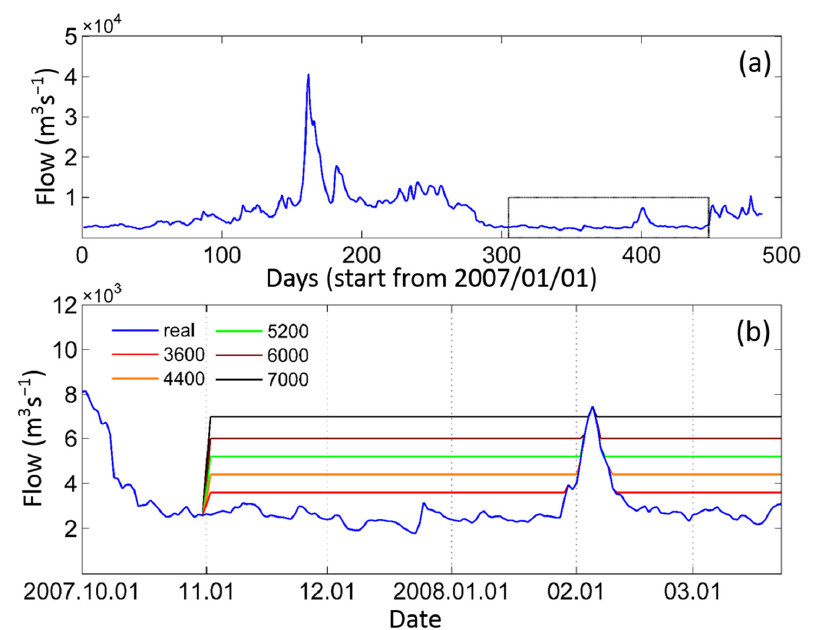
Figure 2. ( a ) River flow of the PRE from 1 January 2007 to 30 April 2008. ( b ) Flow modulation strategy, with the threshold value set to 3000, 3400, 3600, 4000, 4400, 4800, 5200, 5600, 6000, and 7000 m 3 /s for each case. When the measured river flow is lower than the threshold value, the flow is set equal to the threshold value, whereas if it is higher than the threshold value, the flow remains